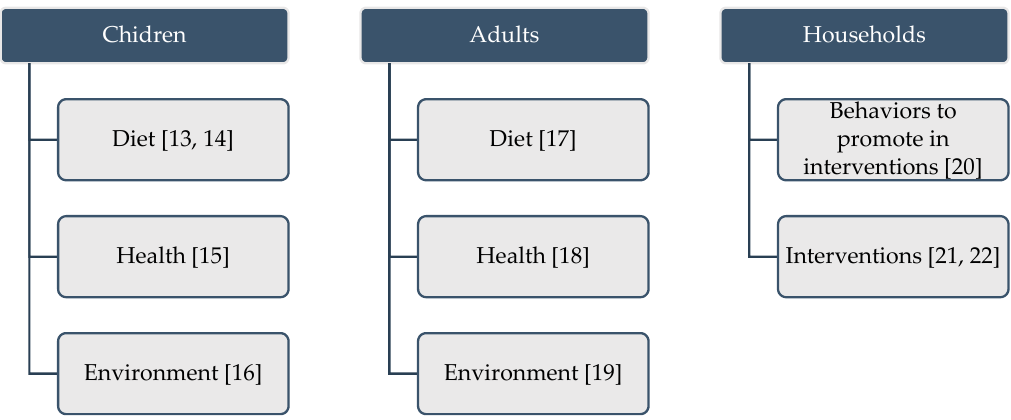
Figure 1. Populations sampled and topical areas of studies included in the Special Issue “Nutrition among Vulnerable Populations”.